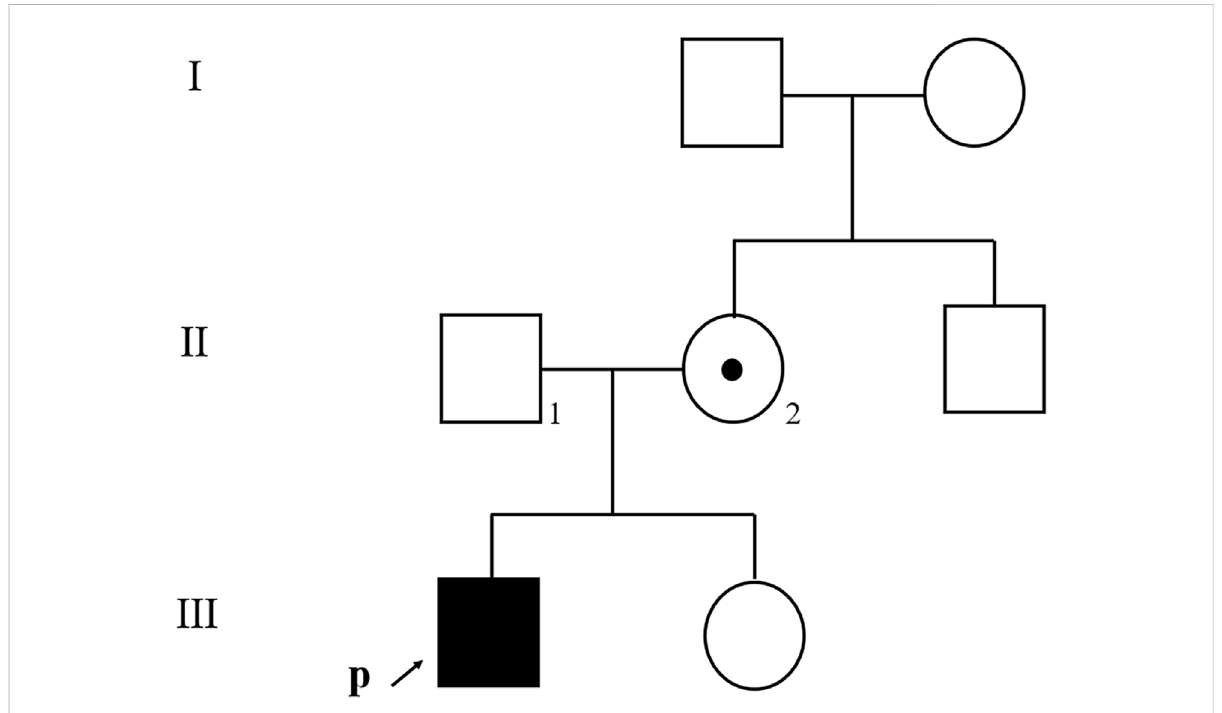
FIGURE 3 Family pedigree chart of the patient. An affected family member is indicated with fi lled symbols; unaffected relatives are indicated by open symbols; a heterozygous carrier is indicated with a dot in the middle of the symbol. Arrows indicate the proband. Numbers are allotted to the family members whose DNA samples were used in this